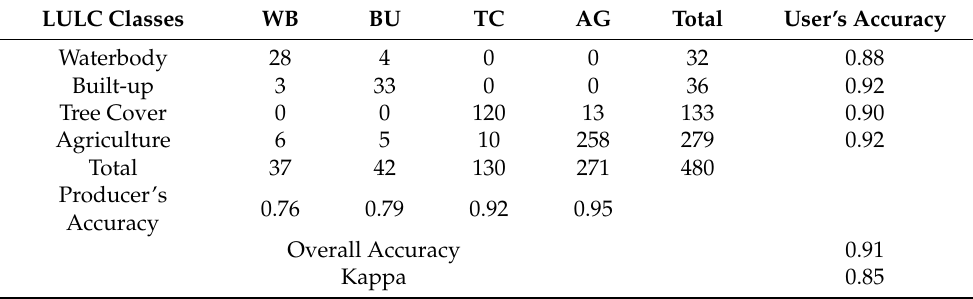
Table 5. Accuracy assessment of LULC of 1988.